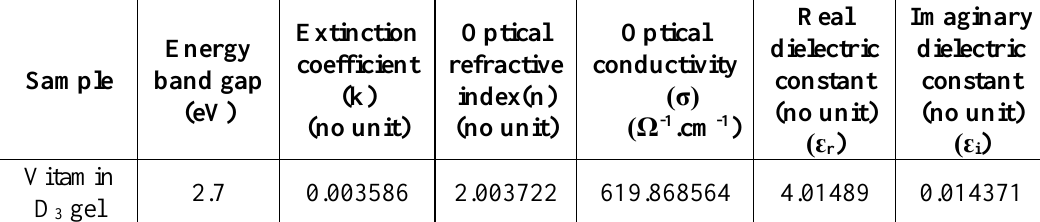
Table 3: Optical parameters of Vitamin D